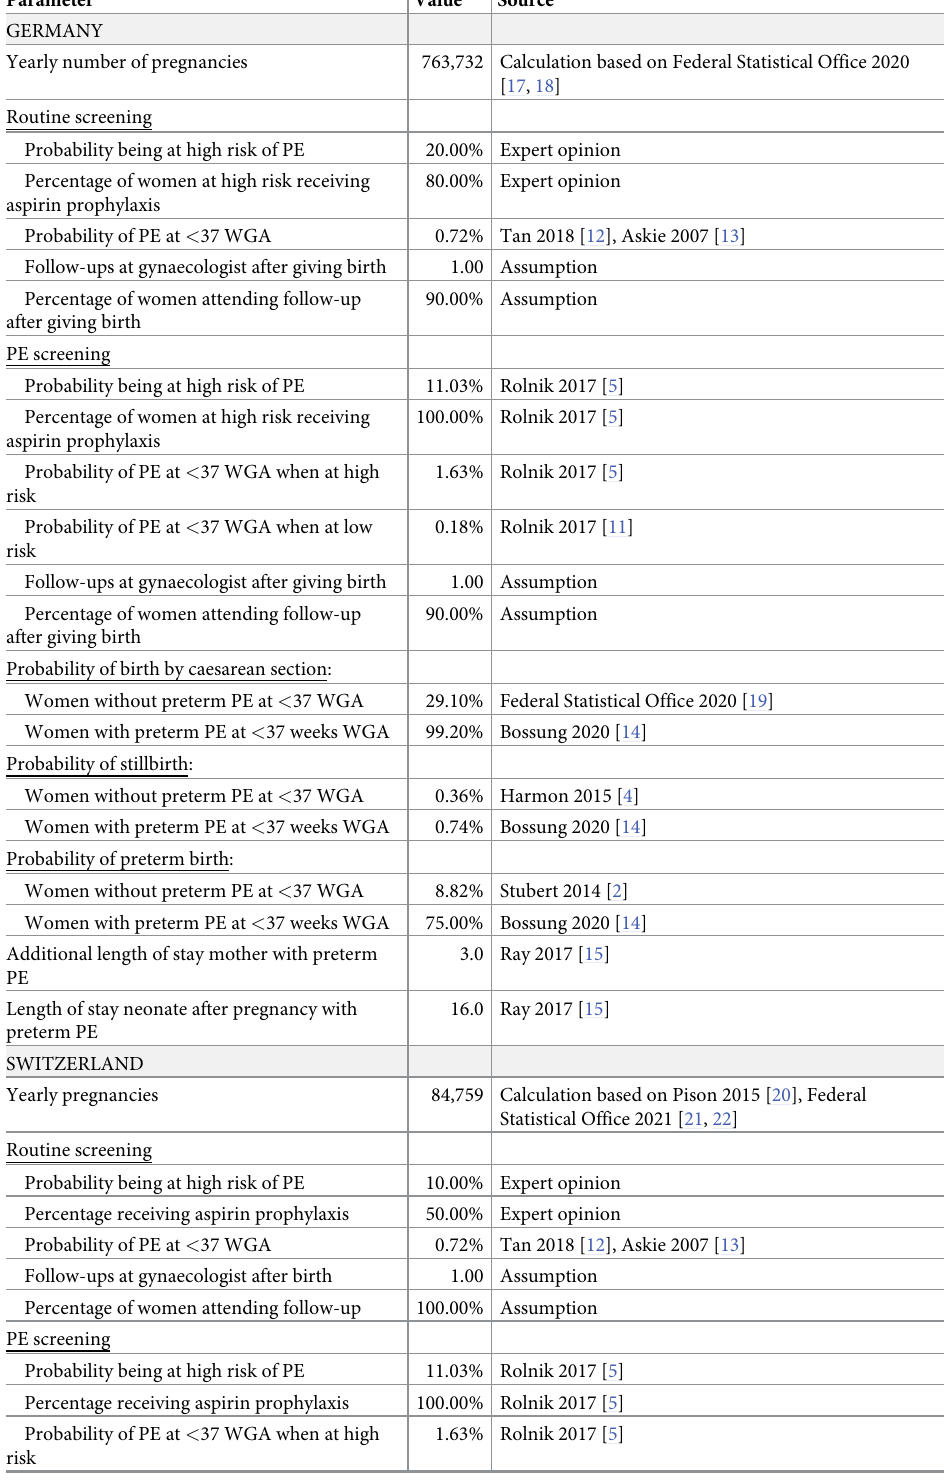
Table 1. Input parameters: Risk of PE and treatment